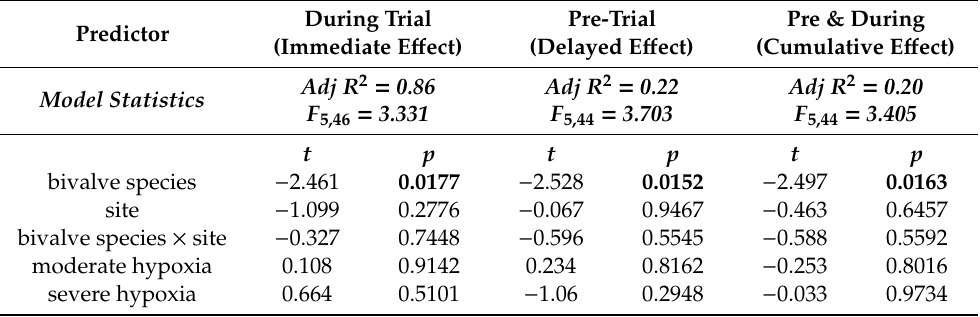
Table 1. Summary of multiple linear regression models of predation mortality, testing for the e ff ect of bivalve species, species × site, duration of moderate hypoxia, and duration of severe hypoxia during, before, and before plus during, predation trials. Significant p -values are in bold.